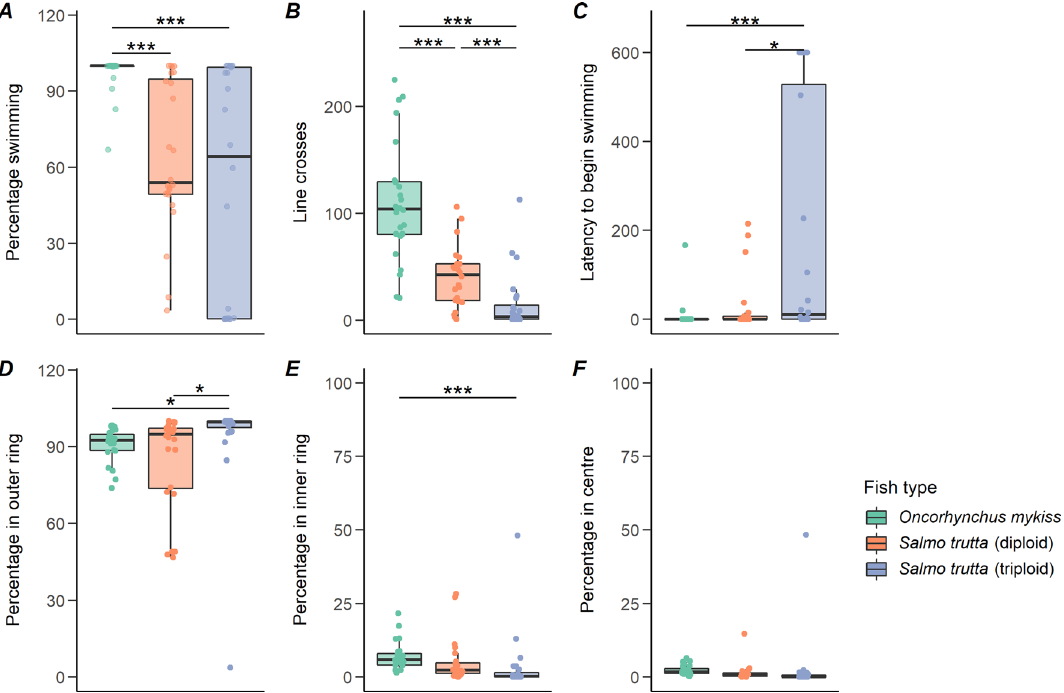
Figure 1. Boxplots showing the variables measured during the open field test, with median and interquartile range plotted and overlayed with raw data points. Asterisks show significance values (* p < 0.05, ** p < 0.01, *** p < 0.001). ( A ) Percentage time spent swimming, ( B ) total number of line crosses, ( C ) the latency to begin swimming from the start of the recording, ( D ) percentage time spent in the outer ring, ( E ) percentage time spent in the inner ring, ( F ) percentage time spent in the centre of the